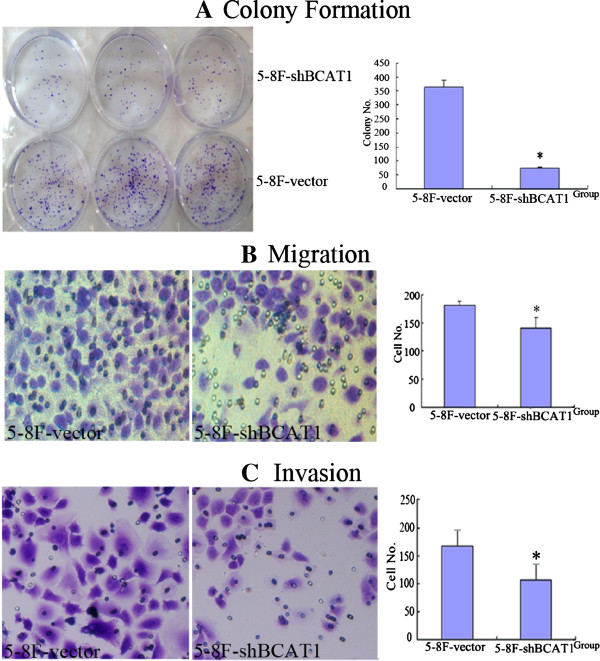
Detection of the colony formation ability, migration and invasion capacities of NPC cells. The colony formation ability (A), migration (B) and invasion capacities (C) of 5-8F cells decreased when the expression of BCAT1 was blocked.